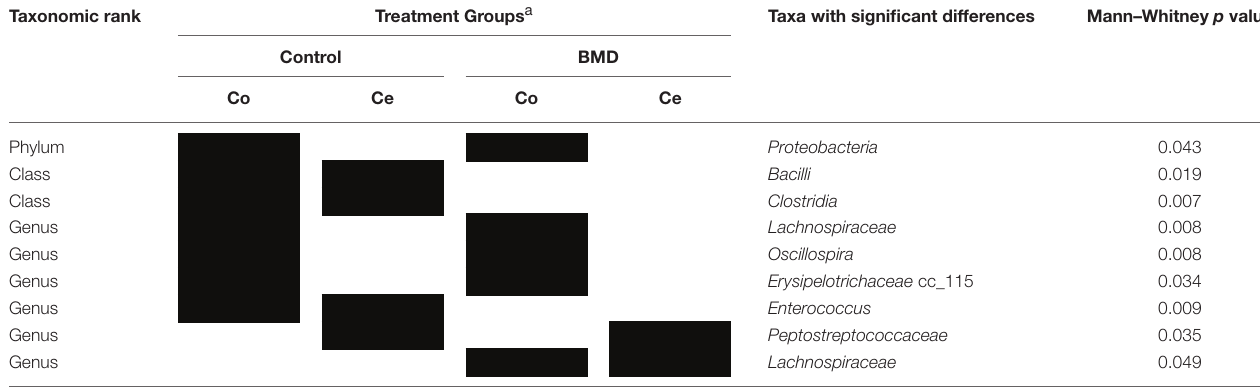
TABLE 2 | Bacterial taxa with significant differences in abundance in pairwise comparisons between treatment groups as determined by Mann–Whitney U